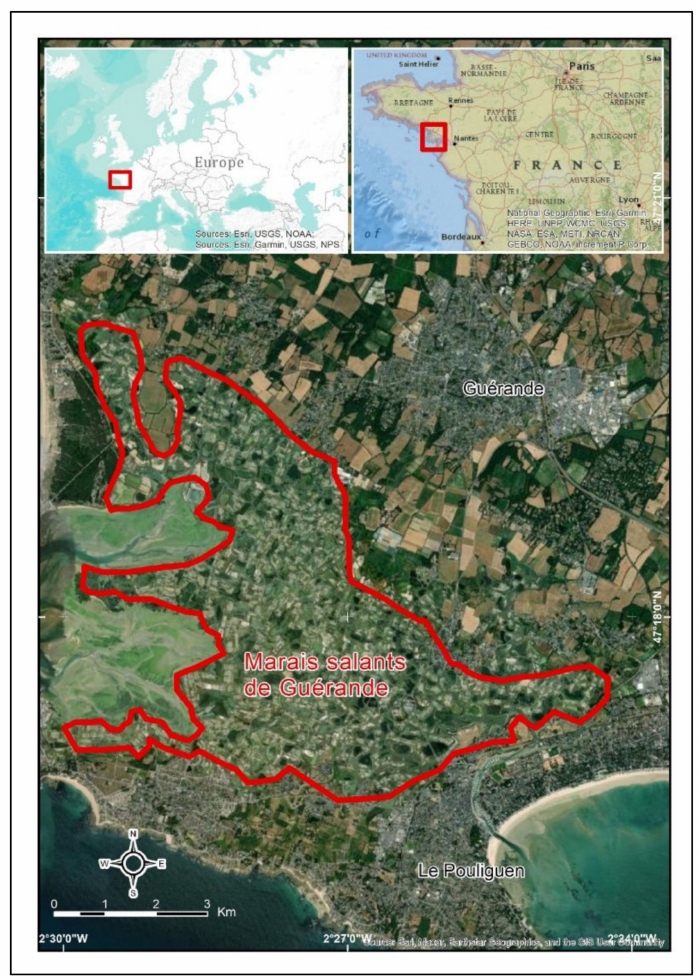
Figure 3. Maps of the study area and location of the Marais salants de Gu é rande (France). The perime- ter of the salina is delimited in red. Source: Own